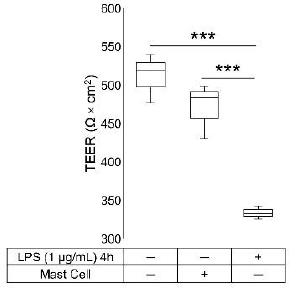
Figure 2. TEER measurement of Caco-2/HT-29 co-culture in the presence or not of HMC-1.2 in the basal compartment and after 4 h LPS stimulation. Statistical analysis: one-way ANOVA followed by Bonferroni’s post hoc, *** p -value < 0.001 ( n = 3).